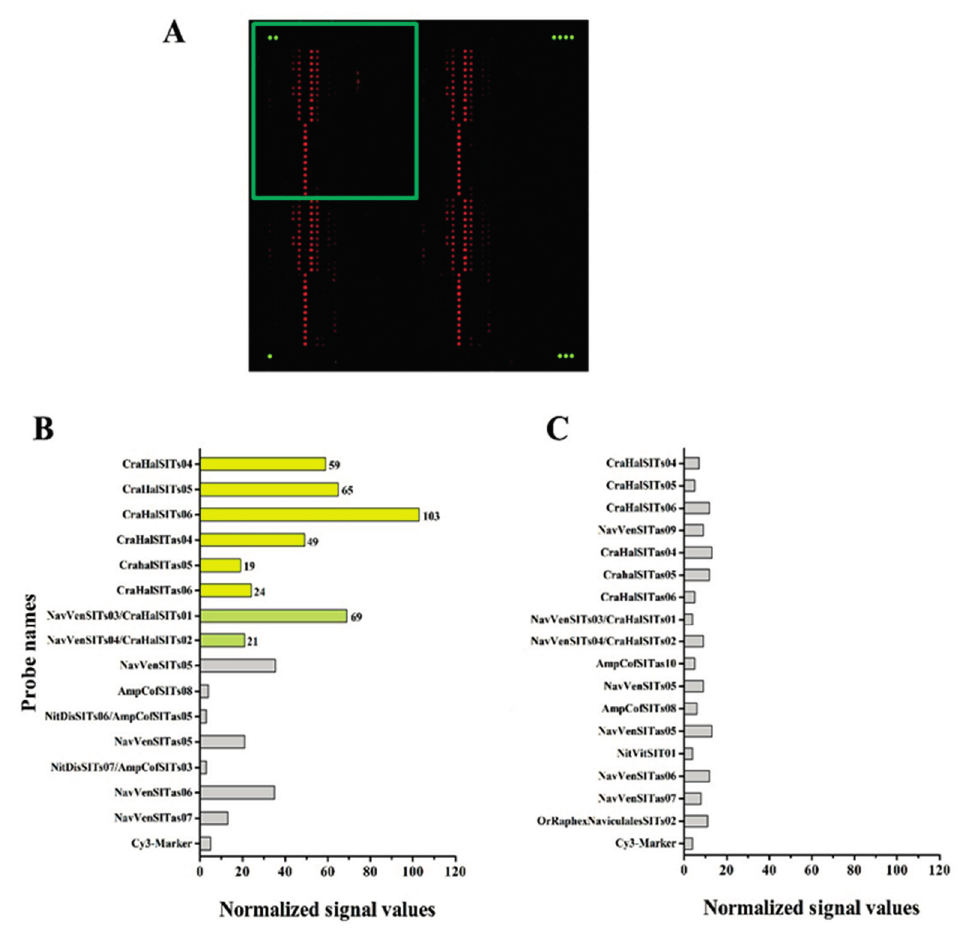
Figure 5. Results of microarray hybridization experiments targeting SIT gene. ( A ) Image of an hybridized slide after scanning: the green dots indicate the Cy3-Marker spotted at the four corners of the slide, the green square indicates one of the four sectors of each block of the array. In the two graphs are reported the values of normalized signals obtained after hybridization with a fluorescent fragment of SIT gene from Craticula halophila ( B ) and Nitzschia palea ( C ). On the Y-axis are reported the probes producing a fluorescent signal after hybridization: the color code of the bars follows the scheme reported in Table S1 and in the text. Grey bars indicate false-positive